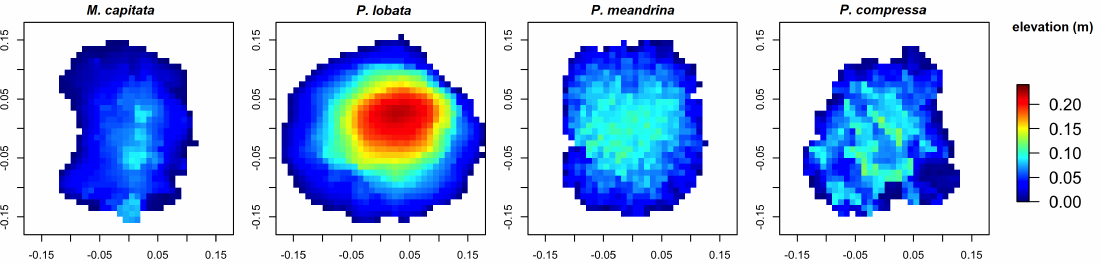
Figure 5. Digital Elevation Models obtained from the four reconstructed coral colonies with different morphologies: encrusting M. capitata , mounding P. lobata , branching P. meandrina and branching P. compressa